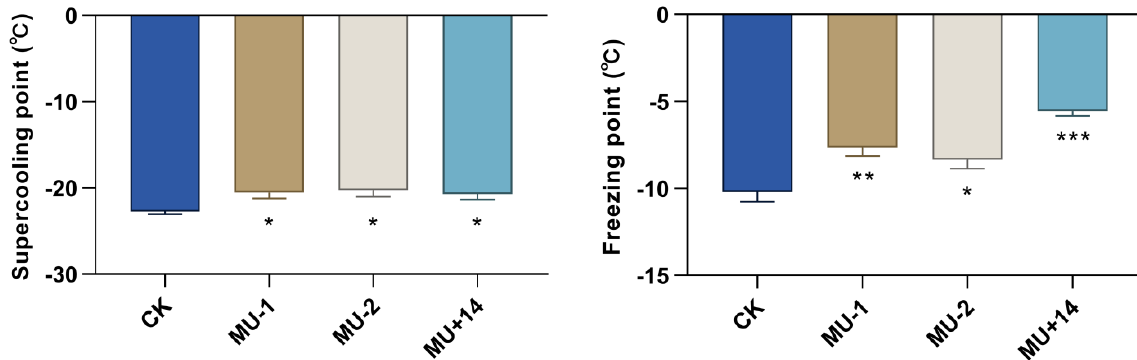
Figure 9. Effects of PxTret1-like knockout on supercooling point and freezing point. Independent- samples t -test was used, and at least 30 pupae of each strain were detected. Error bars represent standard error of the mean. * indicates p < 0.05; ** indicates p < 0.01; *** indicates p < 0.001.